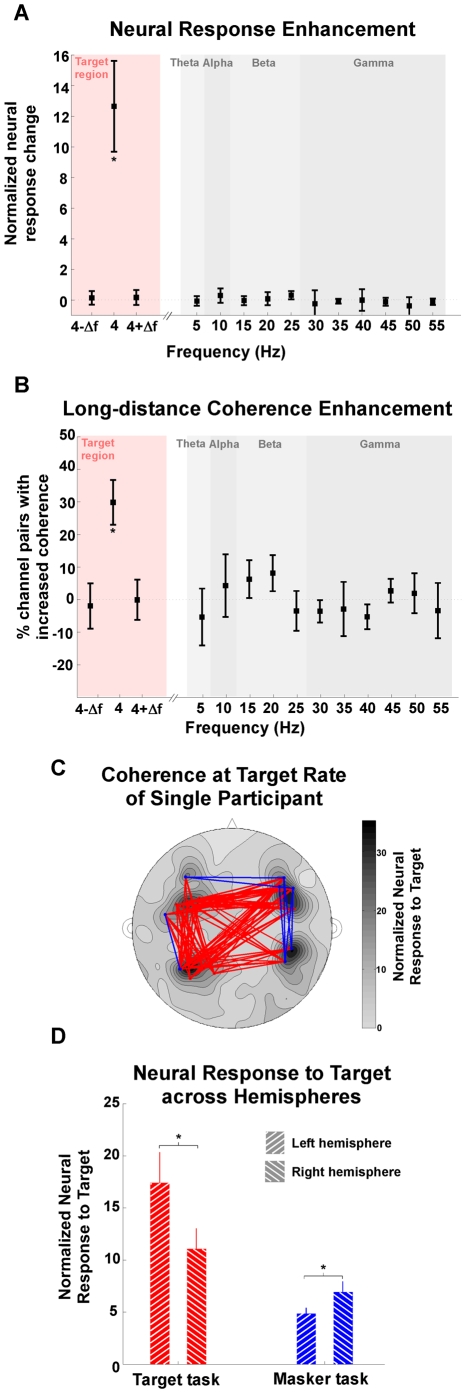
Power and phase enhancement during target task.(A) Normalized neural response of target task relative to masker task shows differential enhancement exclusively at 4 Hz (the frequency of the target rhythm). Each data point represents the difference between normalized neural response of target relative to masker task; error bars represent standard error The asterisk at 4 Hz shows that only that particular frequency yields a statistically significant enhancement. (B) Phase coherence between distant MEG channels of target relative to masker task. The difference between the number of long-range channel pairs with robust increased coherence in target task, and channel pairs with decreased coherence, is normalized over the total number of long-range channel pairs. The phase enhancement is significant (shown with asterisk) only at 4 Hz. (C) Channel pairs with robust coherence difference at target rate for single participant, overlaid on the contour map of normalized neural response at target rate. Each channel pair with enhancement coherence is connected by a red line, whereas pairs with decreased coherence are connected by a blue line. Coherence is only analyzed for the 20 channels with the best normalized response to target rhythm. (D) Neural responses to target across hemispheres. The 20 channels with the strongest normalized neural response at target rate were chosen from the left and right hemispheres, respectively, to represent the overall neural activity of each hemisphere. Neural responses were averaged across the 20 channels, and 14 participants were compared across hemispheres and tasks. The left hemisphere shows stronger differential activation at target rate in target task, whereas the right hemisphere shows stronger activation in masker task (asterisks indicate that the differences are significant).